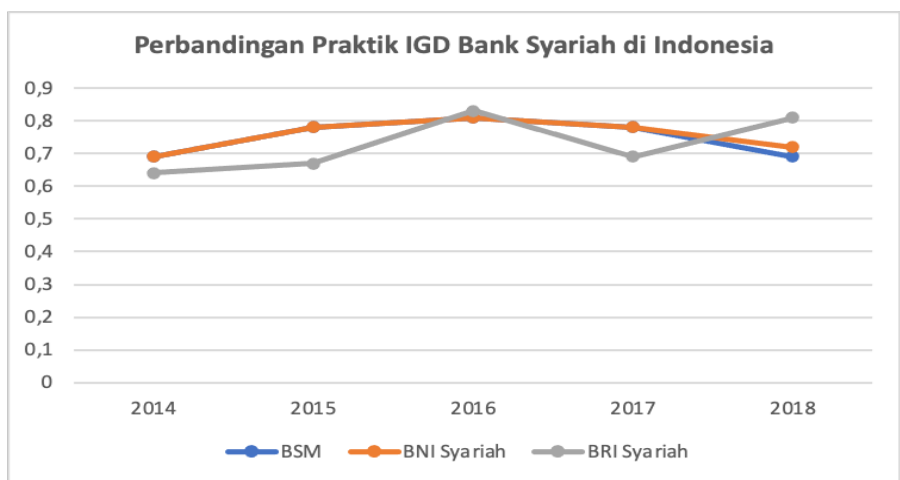
Figure 1. The comparison of IGD practices in Indonesian sharia